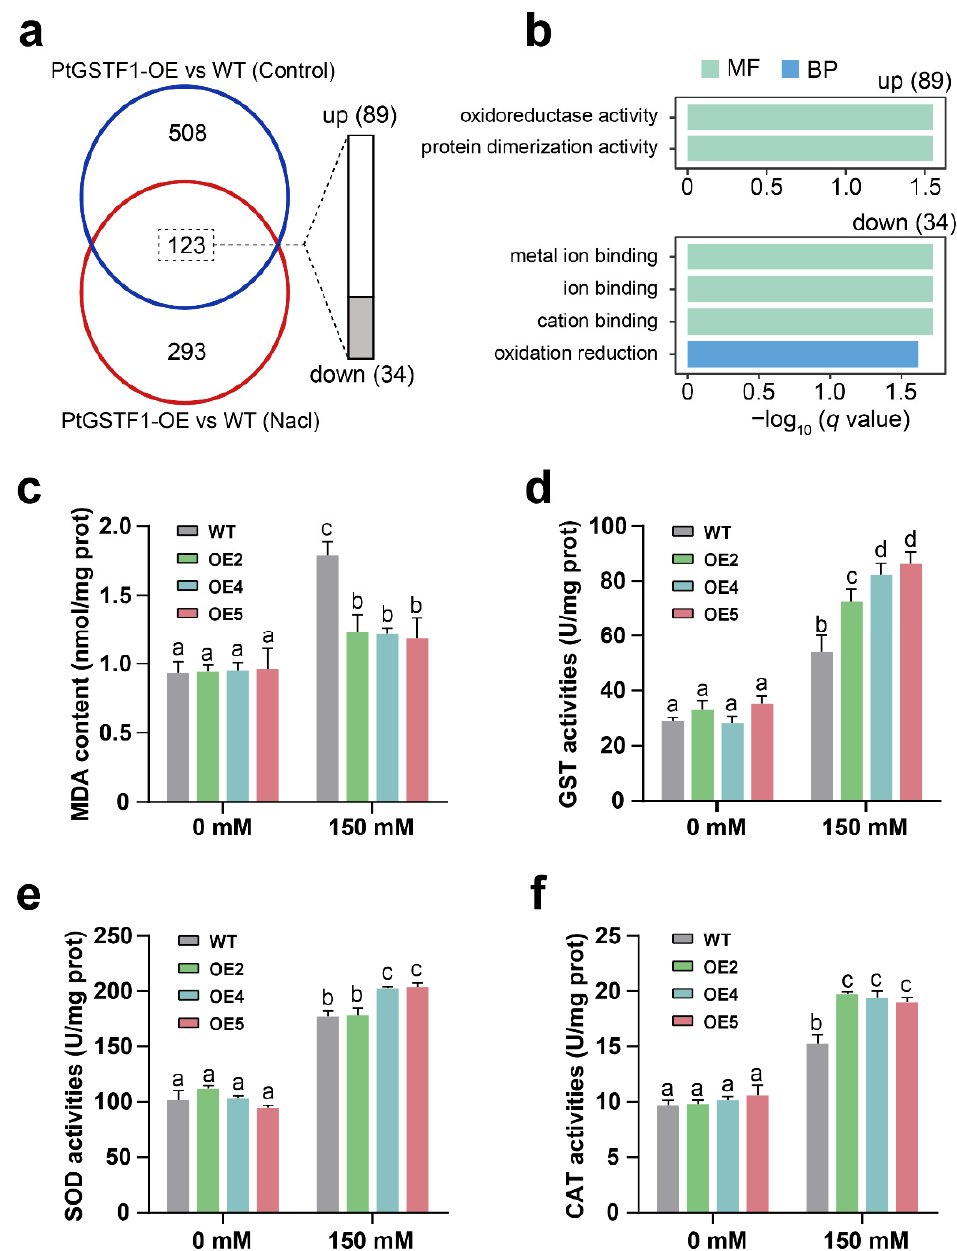
Figure 8. Antioxidant enzyme and glutathione S-transferase activity analyses. ( a ) Venn diagrams showing the numbers of DEGs between wild type and transgenic line OE5 plants treated with 0 and 150 mM NaCl. ( b ) GO Terms for up-regulated (89) and down-regulated (34) DEGs (FDR adjusted p -value < 0.05). MF, molecular function; BP, biological process. ( c ) MDA content. ( d – f ) GST, SOD and CAT activities. Four − week − old wild type (WT) and transgenic lines (OE2, OE4, OE5) were treated with 0 or 150 mM NaCl for 4 weeks. Values are the mean ± SD from three independent experiments ( n = 3). The lowercase letters reflect the levels of statistical significance of one-way ANOVA with Tukey’s HSD test ( p <